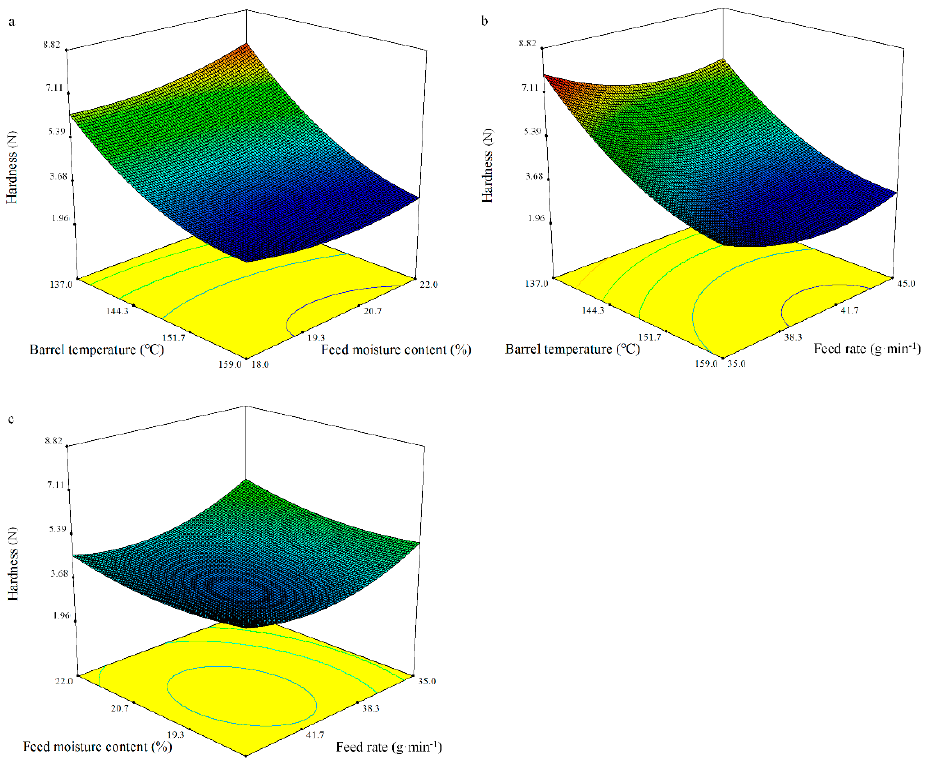
Figure 3. Response surface plot of the hardness of the whole BGW extrudates.